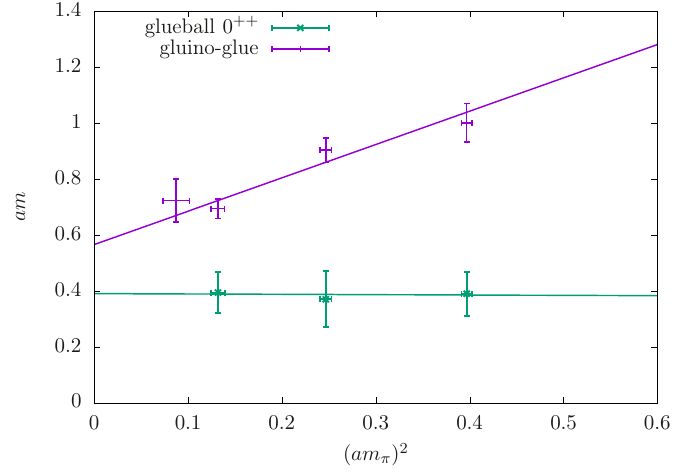
Figure 10. The masses of the fermionic gluino-glue and the bosonic 0 ++ glueball at β = 5 . 4 in lattice units. The figure includes an extrapolation of the chiral limit based on a linear fit.